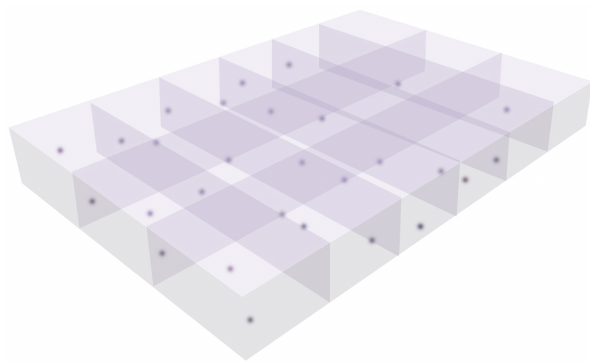
Figure 6. PL/SQL statement inserting a triangle to the TRIANGLES table.